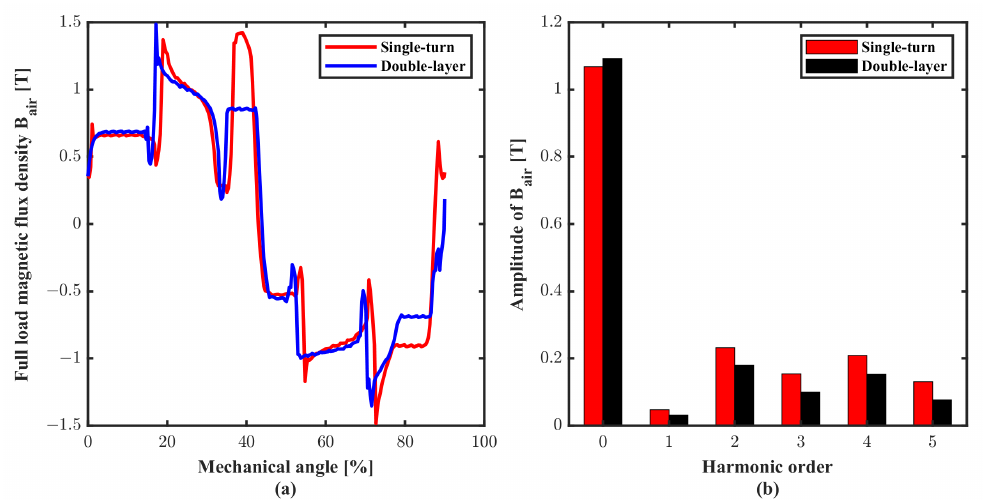
Figure 13. ( a ) Full load air-gap magnetic flux density distribution. ( b ) Harmonic components of air-gap magnetic flux density.